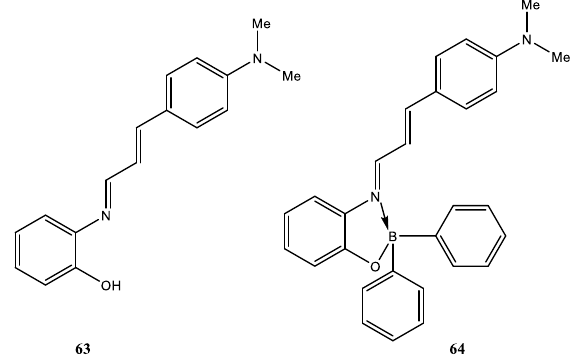
Figure 18. Structures of bidentate ligand ( 63 ) and boronate ( 64 ).